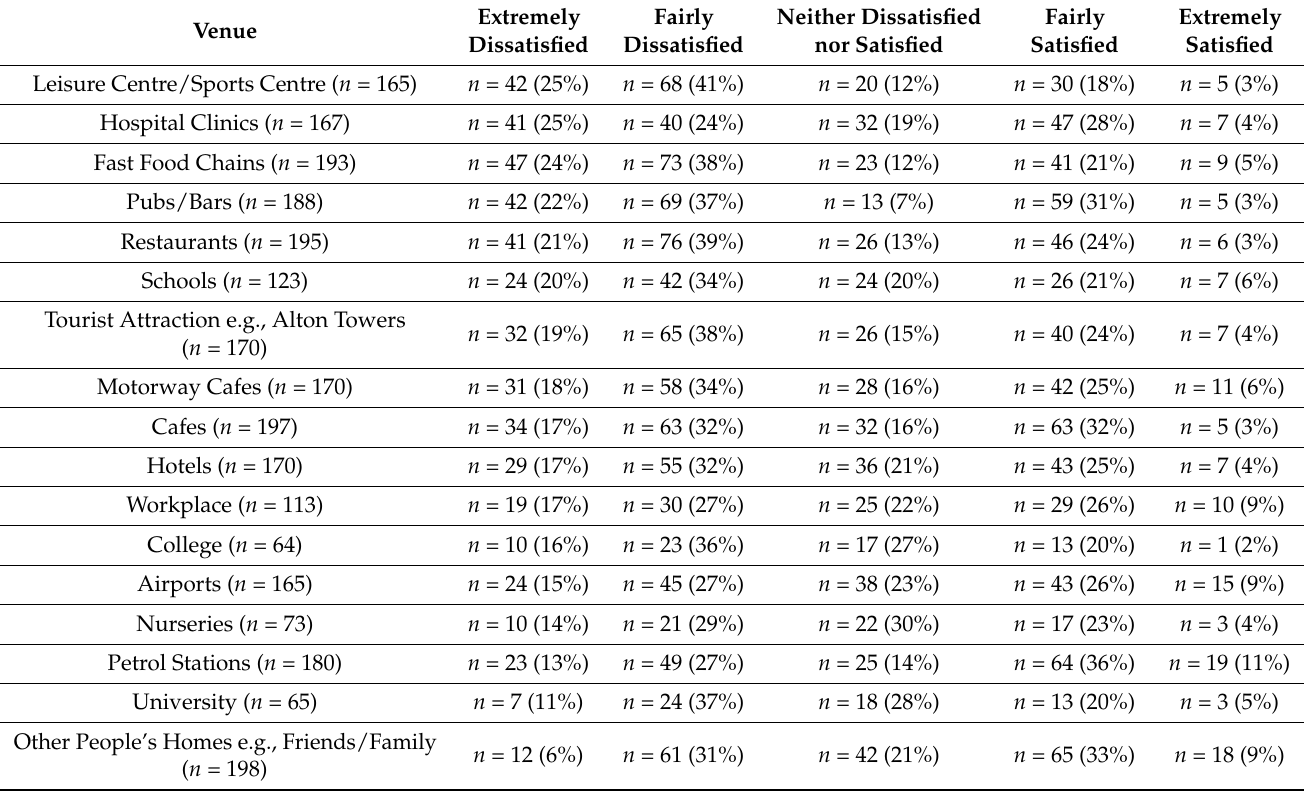
Table 1. Satisfaction with the range of drinks across various